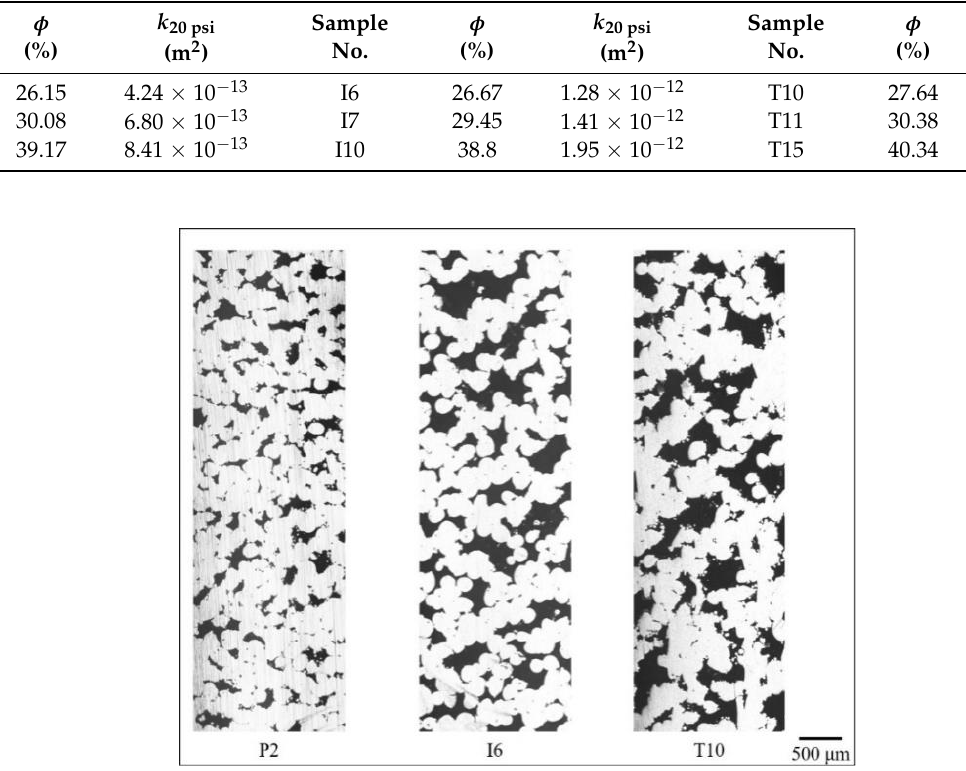
Figure 7. Flow paths in P2, I6, and T10 samples (lateral direction corresponds to z or printing direction in SLM.).